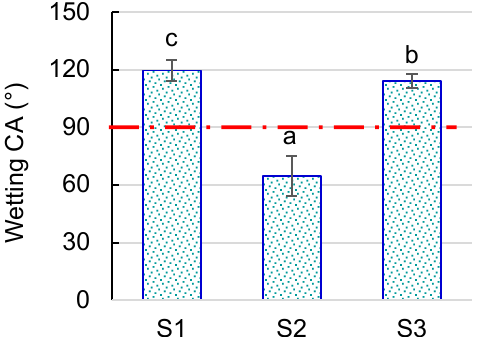
Figure 5. The mean of the wetting contact angle (wetting CA) with standard deviation as the potential SWR for the 0–5 cm soil layer for the three sites. The red dashed line, the wetting contact angle = 90 ◦ , is the boundary between wettable and water-repellent soil. Note: different letters denote significant differences between sites, as determined with the Kruskal—Wallis test ( α = 0.05).